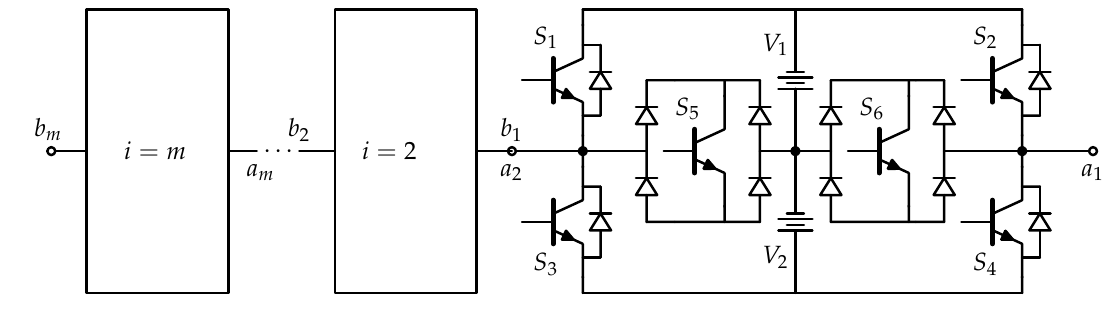
Figure 2. m cascaded units to generate more voltage levels.